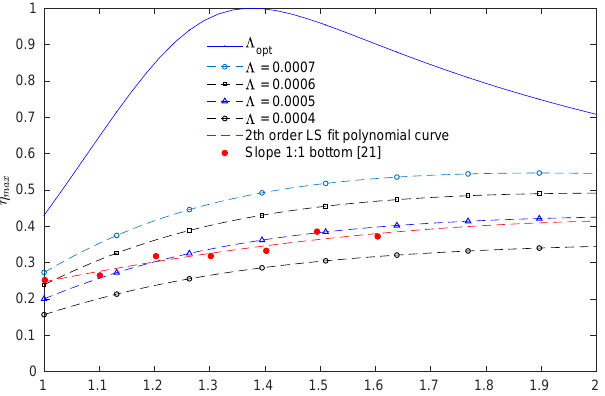
Figure 12. Hydrodynamic efficiency versus period T for different values of linear turbine damping coefficient Λ , without considering the